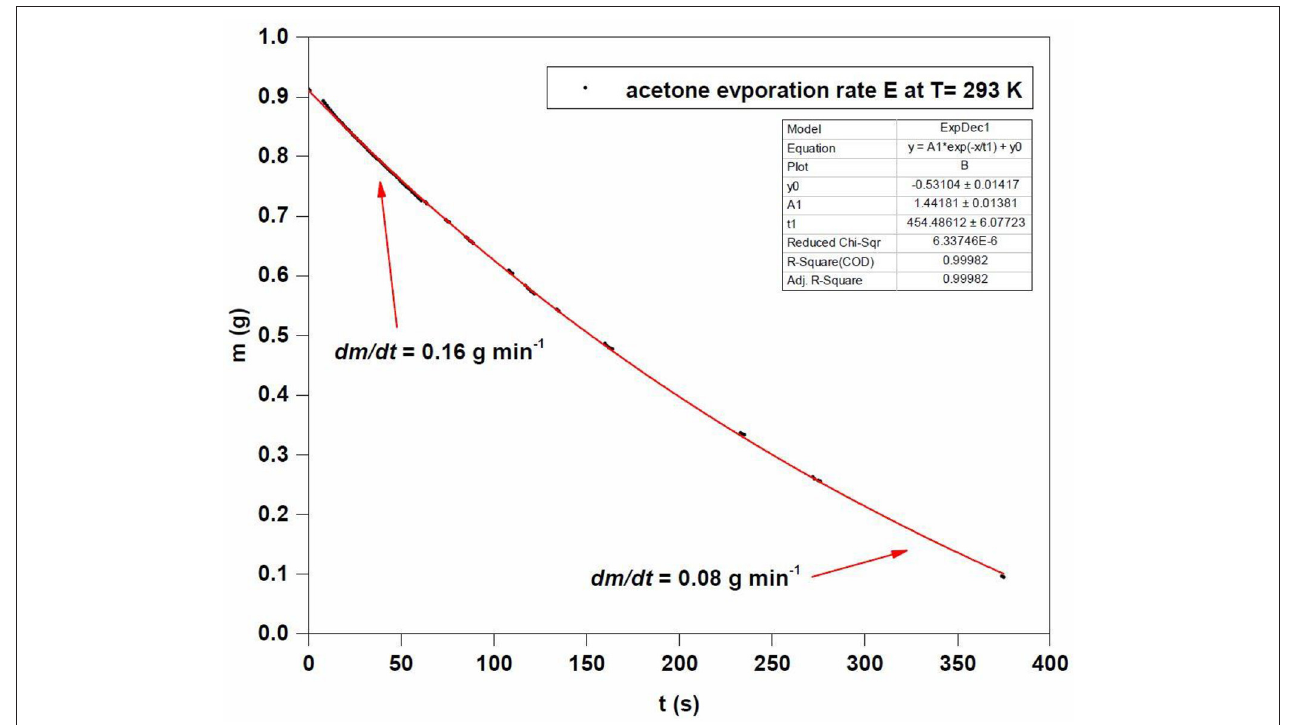
FIGURE 9 | Evaporating sample mass vs. time dependence, and Acetone evaporation rate E = dm/dt at T = 23 ◦